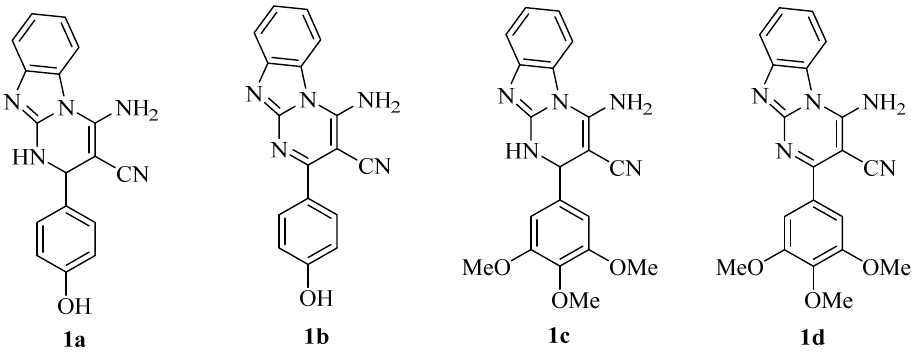
Figure 1. Structures of known pyrimidobenzimidazoles with documented anticancer activity.